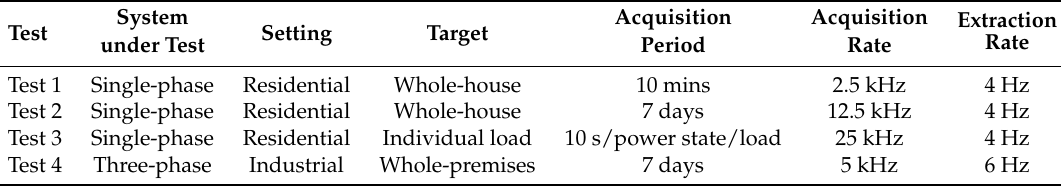
Table 3. Tests of single-phase and three-phase systems under different scenarios and acquisition parameters.